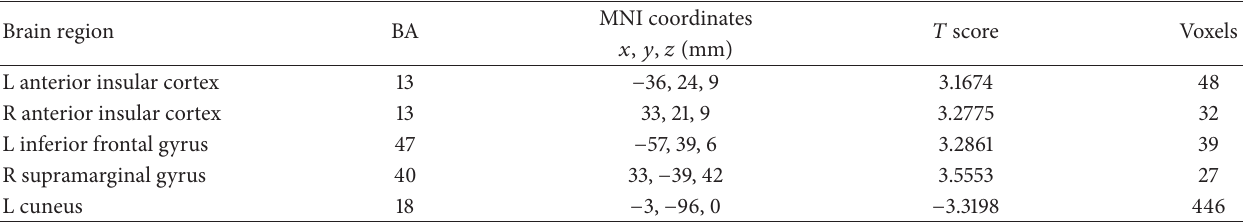
Table 3: Differences in ReHo between tinnitus patients and healthy controls.